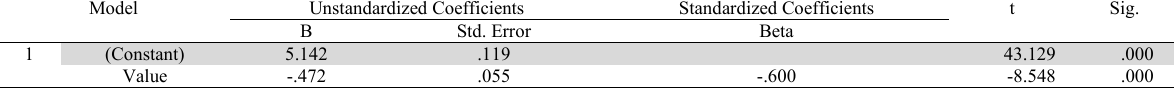
The summary of the results of regression analysis between lack of values and ethics-based decision making